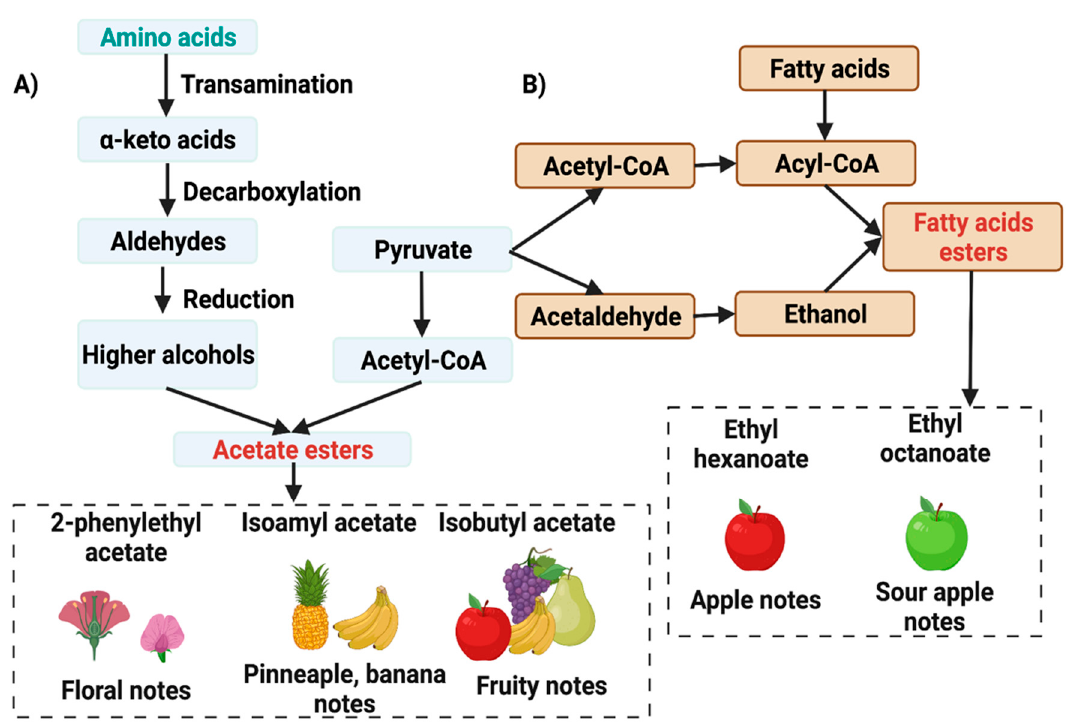
Figure 4. Formation of flavor precursors by yeast during fermentation via ( A ) Amino acids and ( B ) Fatty acids substrates. Yeast autochthonous to the cocoa fermentation process can produce higher alcohols either catabolically, through the Ehrlich pathway involving transamination, decarboxylation, and dehydrogenation of amino acids; or anabolically, as by-products of amino acid biosynthesis from pyruvate during the cocoa fermentation process. Table 1. Main VOCs and sensory descriptors produced by yeasts in cocoa bean fermentation. Yeasts VOC Sensory Descriptor